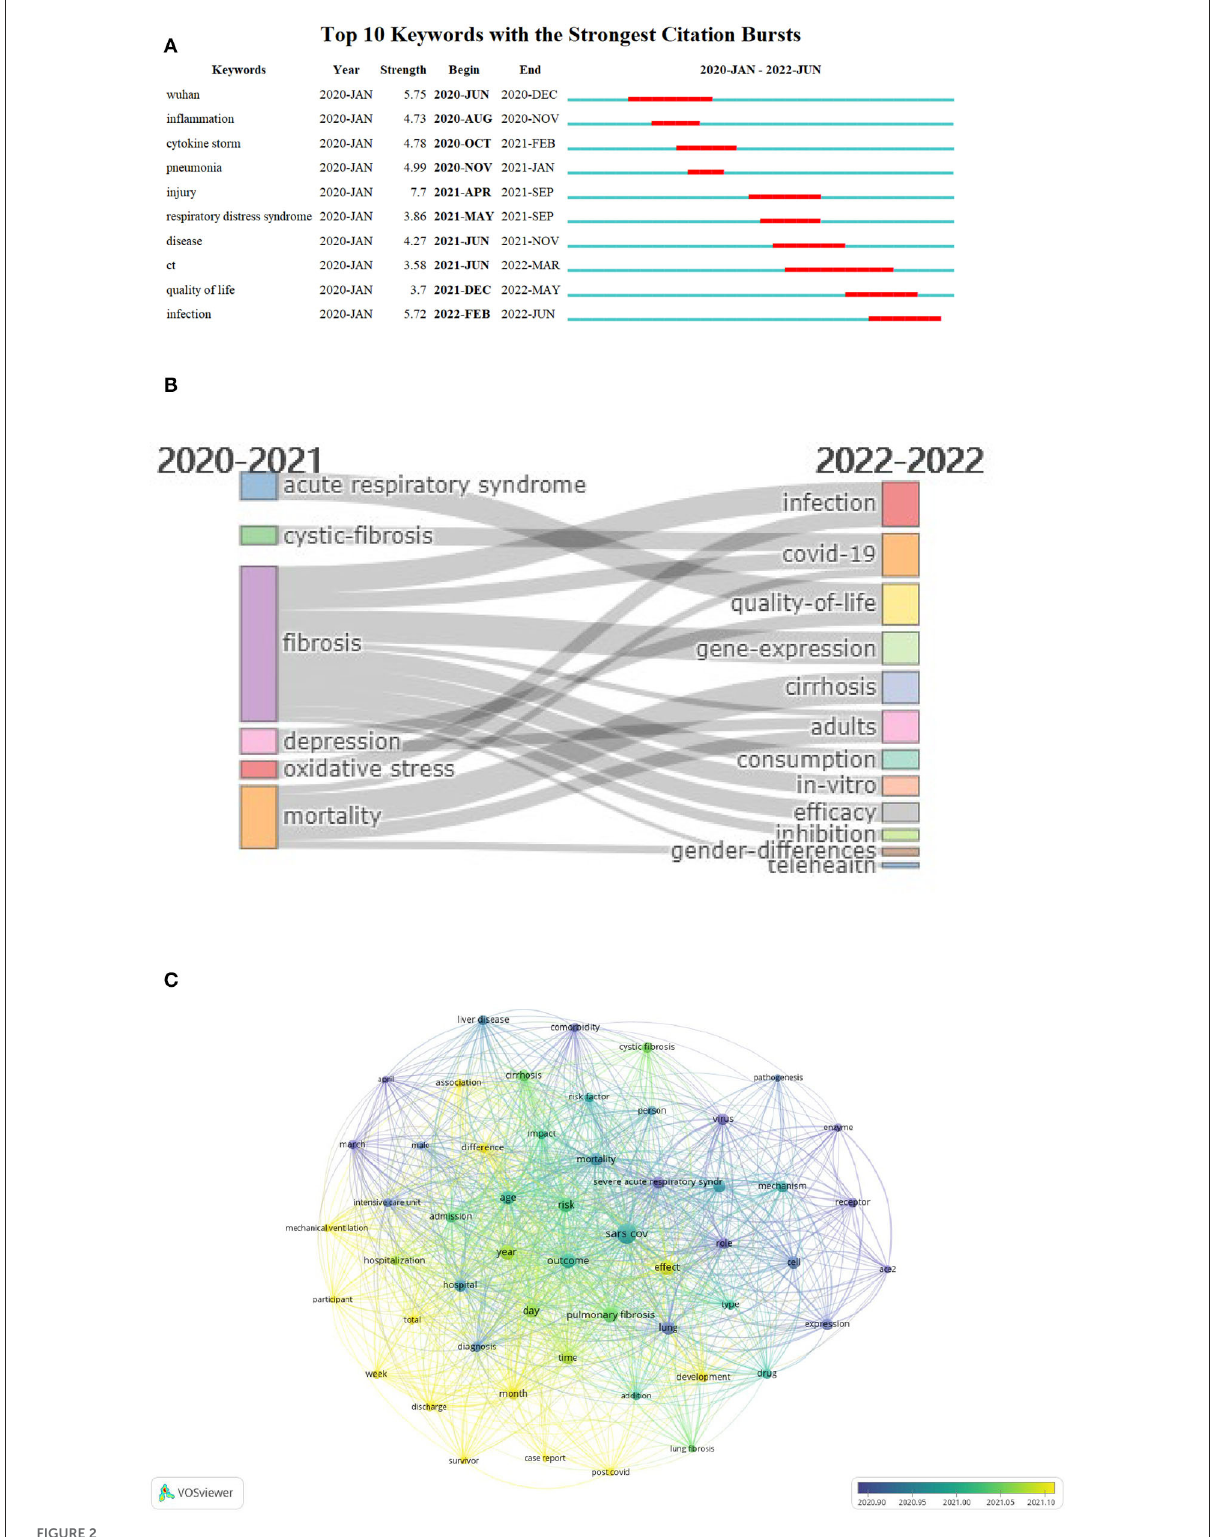
FIGURE2 Time view of keywords. (A) Top 10 most bursting keywords between 2020 and 2022. The red bar indicated the appearance time span of keywords. (B) Thematic evolution between 2020 and 2022. The cutting point of time slices is 2021. (C) Overlay visualization of thematic terms. The bubble colors indicated the average publication date of particular words. The purple color indicated the former publication date. The yellow color indicated later publication